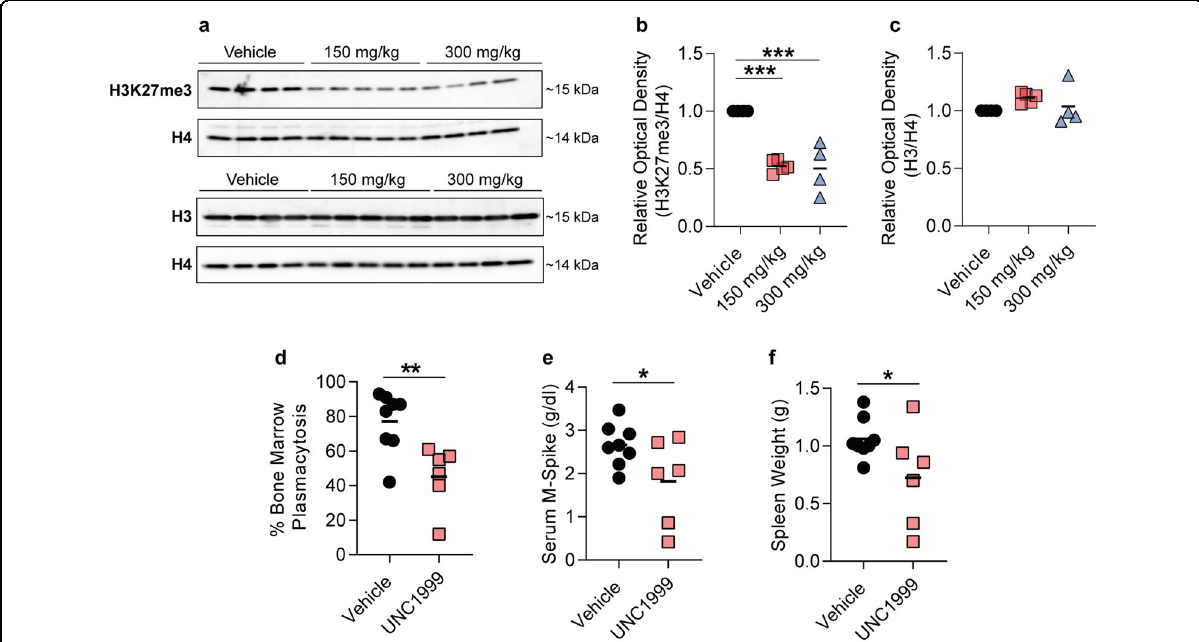
Fig. 1 EZH2 inhibition signi fi cantly reduced tumour burden in mice bearing 5T33MM multiple myeloma. a Western blot against H3K27me3 and total histone H3 (H3) of bone marrow plasma cells derived from 5T33MM mice treated with 150 or 300 mg/kg of UNC1999, or with vehicle. Total histone H4 (H4) was used as a loading control. Corresponding uncropped western blots can be found in Supplementary Fig. 9a – b. b Signal quanti fi cation of the western blot against H3K27me3 shown in ( a ). c Signal quanti fi cation of the western blot against H3 shown in ( a ). The optical density in ( b – c ) was normalized against H4. n (Vehicle) = 4, n (150mg/kg) = 5 and n (300mg/kg) = 4. Statistical analysis in ( b – c ) was performed with one-way ANOVA. Values: mean with SEM. d – f 5T33MM mice were treated with 200 mg/kg of UNC1999 or with vehicle. Tumour load was determined by d bone marrow plasmacytosis, e M-spike levels and f spleen weight. n (Vehicle) = 8, n (UNC1999) = 6. Statistical analysis in ( d – f ) was performed with one-sided t -test. Values: mean with SEM. * p < 0.05, ** p < 0.01, *** p < 0.001, **** p <